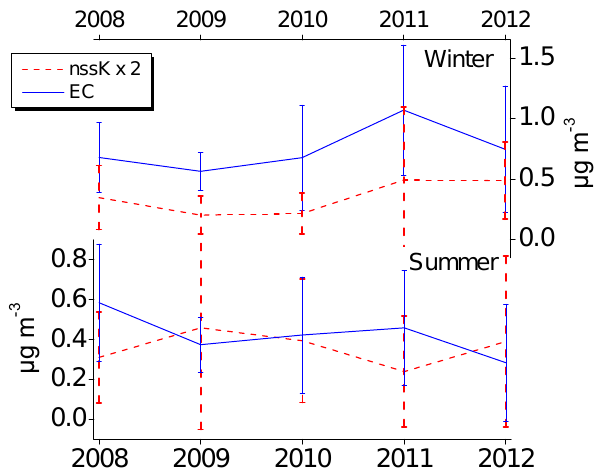
Figure 8. Average seasonal cycles of OC and EC concentrations at Penteli, Athens, and Finokalia, Crete, calculated from daily values, for the period May 2008–April